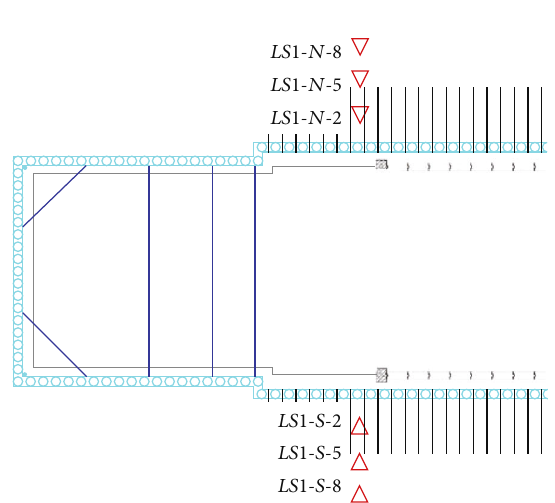
Figure 2: Schematic of monitoring